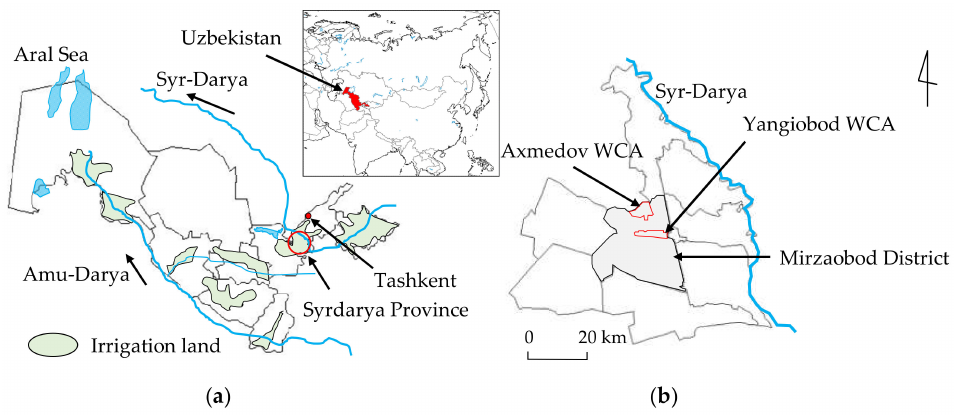
Figure 1. Location maps of the study site: ( a ) Irrigation land and Syrdarya Province in Republic of Uzbekistan; ( b ) Axmedov Water Consumers’ Association (WCA) and Yangiobod WCA in Mirzaobod District, Syrdarya Province.